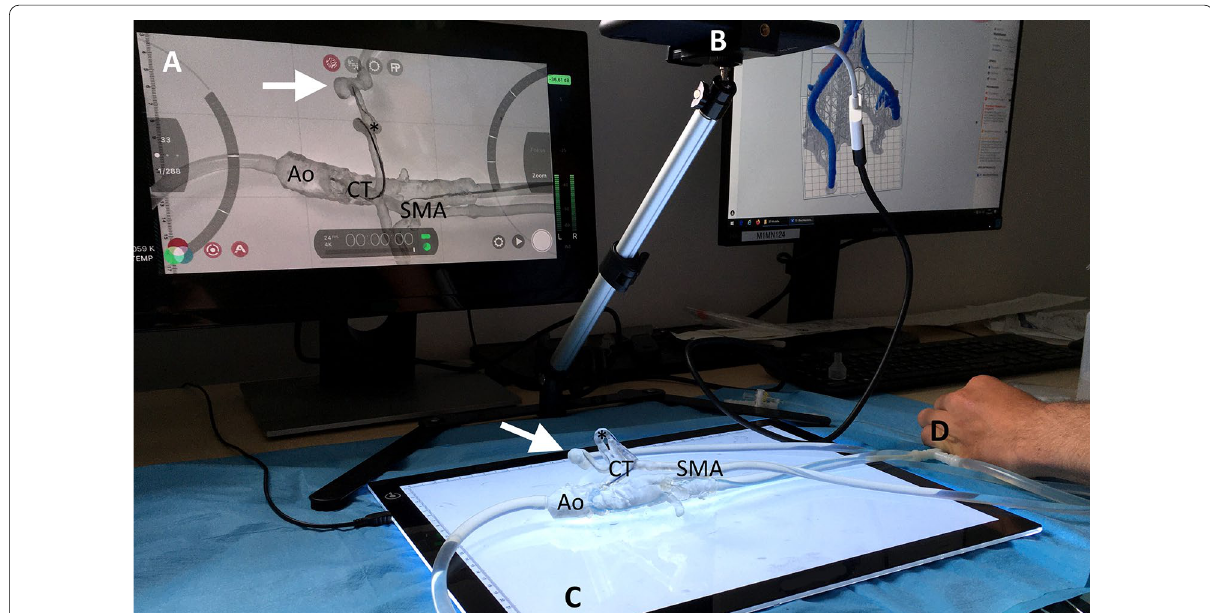
Fig. 5 Procedural simulation. A trainee practicing the catheterization of a splenic artery with pseudoaneurysm (white arrow). A 5-French Cobra C2 catheter is placed in the celiac trunk and a microcatheter with guidewire is advanced to the splenic artery. A 2D projection of the simulation model, B Smartphone camera on a tripod, C LED panel for improved visibility, D 5-French introducer sheath, Ao mesenteric artery, * splenic =